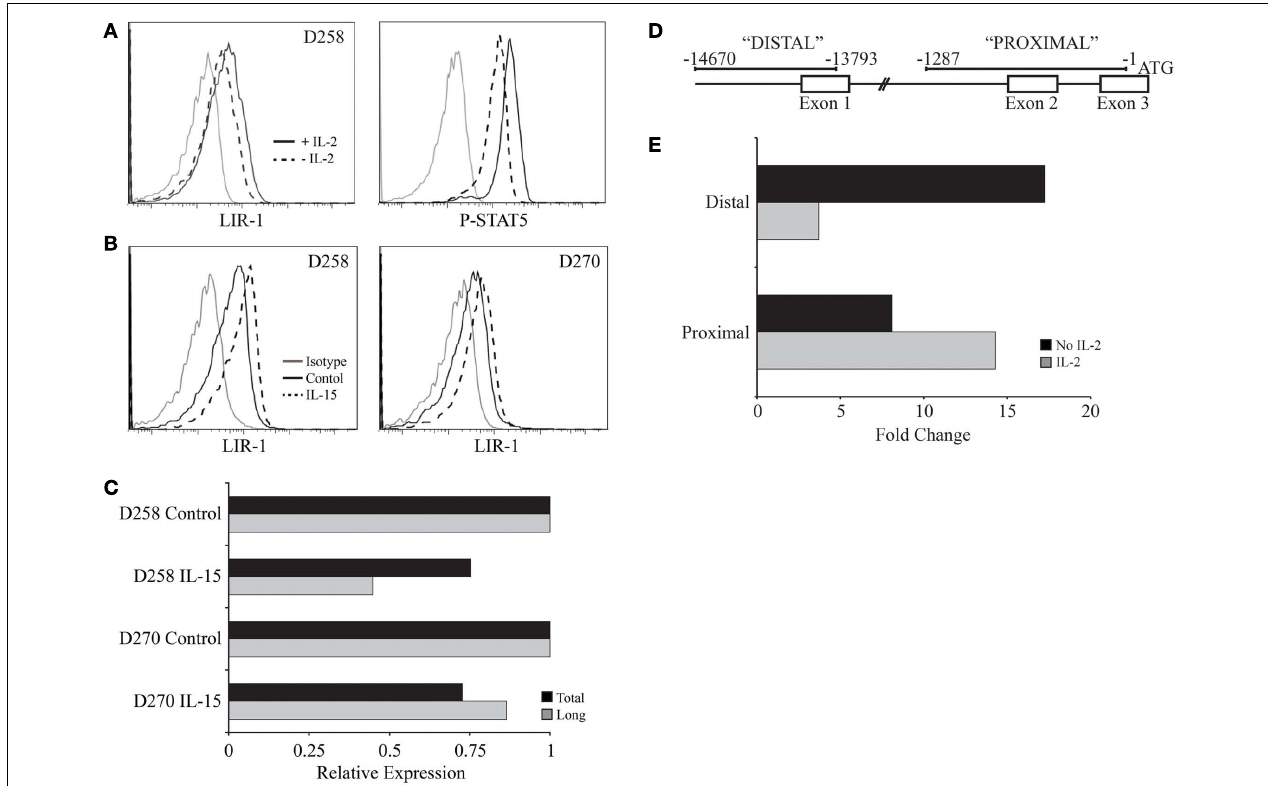
PCR analysis of the total LIR-1 transcript and the long LIR-1 transcript present in NK cells depicted in (B) .Values are normalized to the RPL24 transcript and presented relative to control treated NK cells for each donor. (D) Illustration of the regions used for measuring promoter activity. (E) Differential effect of IL-2 on the activity of the two LIR-1 promoter regions.The luciferase activity was measured inYTS cells cultured in the presence or absence of IL-2 for 38h. Data is representative of two out of three separate